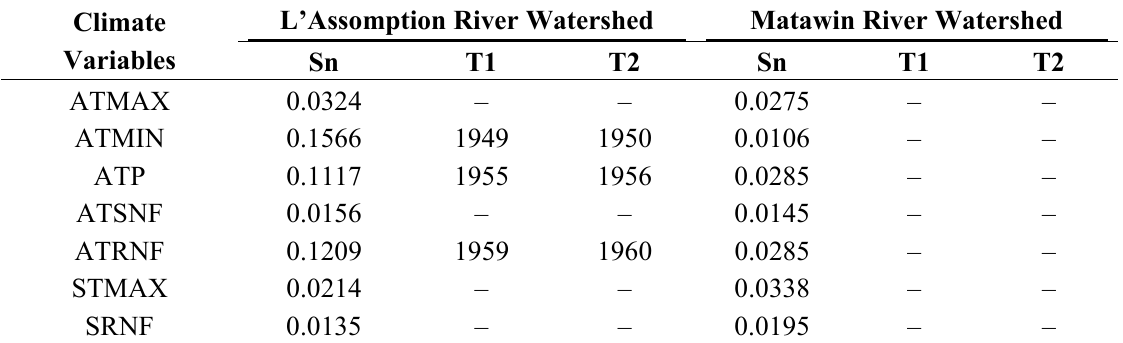
Table 3. Comparison of the stationarity of climate variables in the two watersheds using the Lombard method (1930–2010)